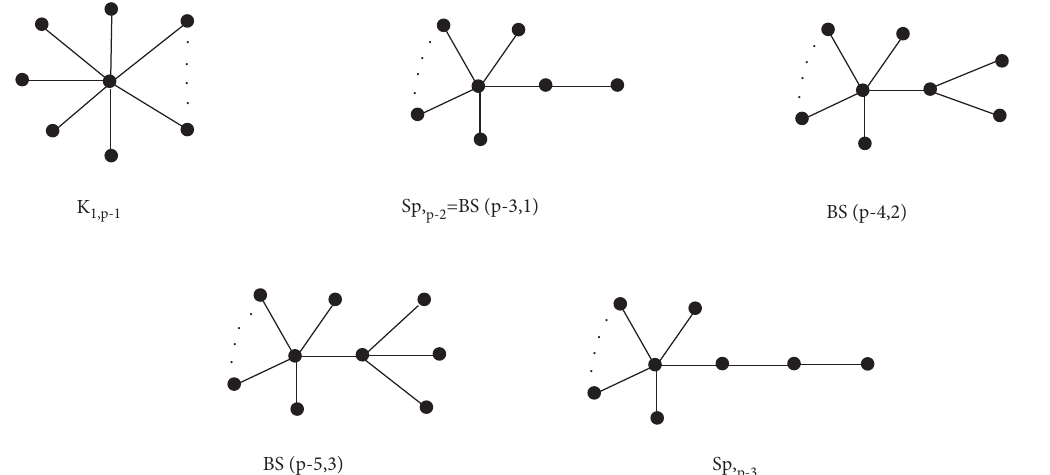
Figure 6: Acyclic connected graphs T having greatest M